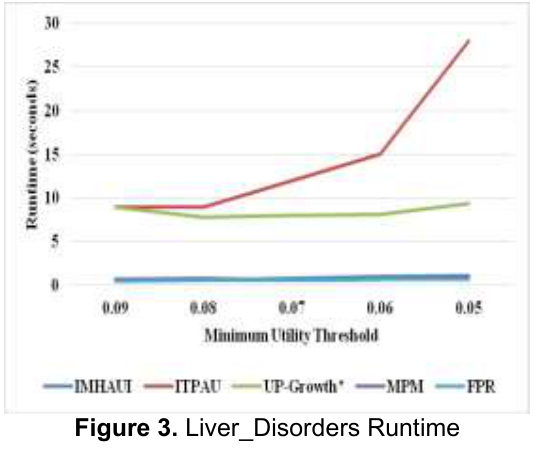
Figure 3. Liver_Disorders Runtime